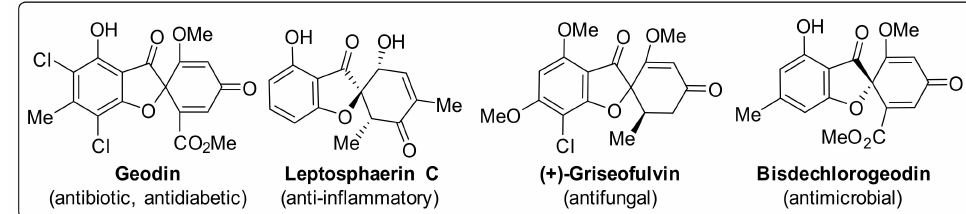
Figure 1. Naturally occurring bioactive products with spirobenzofuran-3-one